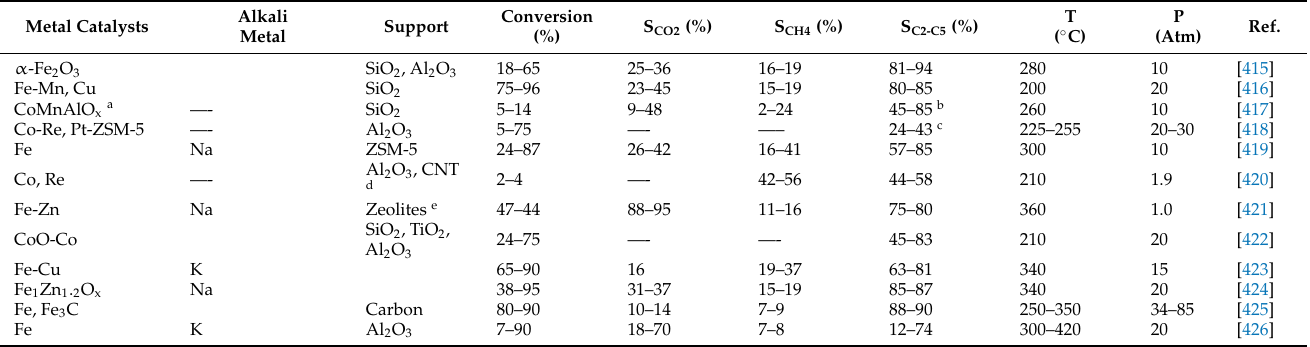
Table 12. Comparative summary of different catalytic systems for Fischer-Tropsch (FTS) improving the direct conversion of the water-gas-shift reaction (WGSR) to light